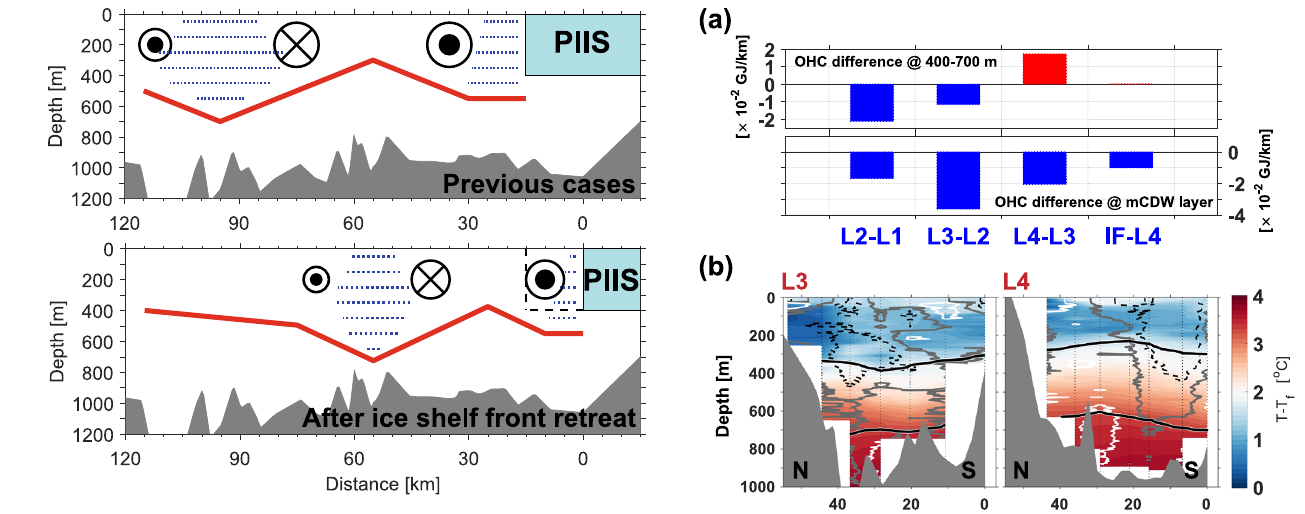
Fig. 3 Schematic fi gure representing the location of the double-gyre and related meltwater distribution in PIB. The upper and lower panels indicate oceanic conditions before (previous cases) and after the ice shelf front retreat, respectively (not to scale). The dashed black line in the lower panel indicates the ice shelf front position in the previous cases before the retreat. Dotted blue lines represent the water column with a high meltwater content. The thick solid red line shows the approximate variation in the isopycnals (also thermocline) associated with the meltwater distributions in fl uenced by the counter-rotating double gyres. The circles with crosses and dots denote the ocean fl ows into and out of the plane of the diagram, respectively; their sizes indicate the relative fl ow speed and volume transport.